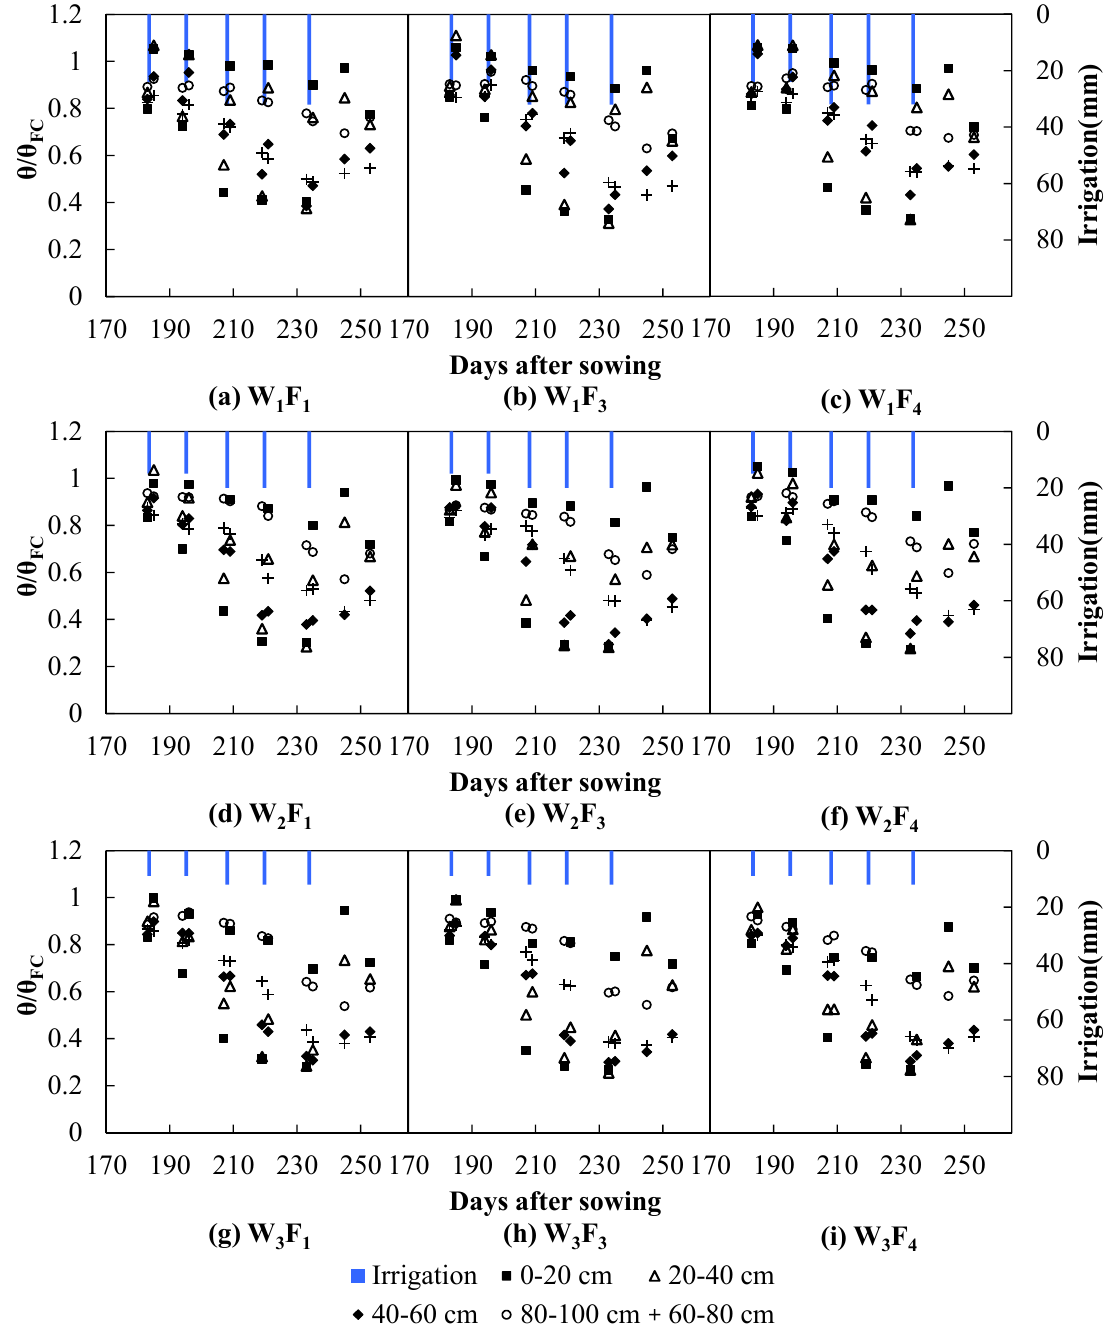
Figure 3. Temporal variation in relative soil moisture ( θ / θ FC ) during the 2013 winter wheat growing season for nine treatments: W 1 , W 2 and W 3 , irrigations scheduled according to 0.8, 0.5 and 0.3 cumulative evaporation of 20-cm-diameter pan (E), respectively; F 1 : N application at 120 kg·ha − 1 ; F 3 : N application at 190 kg·ha − 1 ; and F 4 : N application at 290 kg·ha − 1